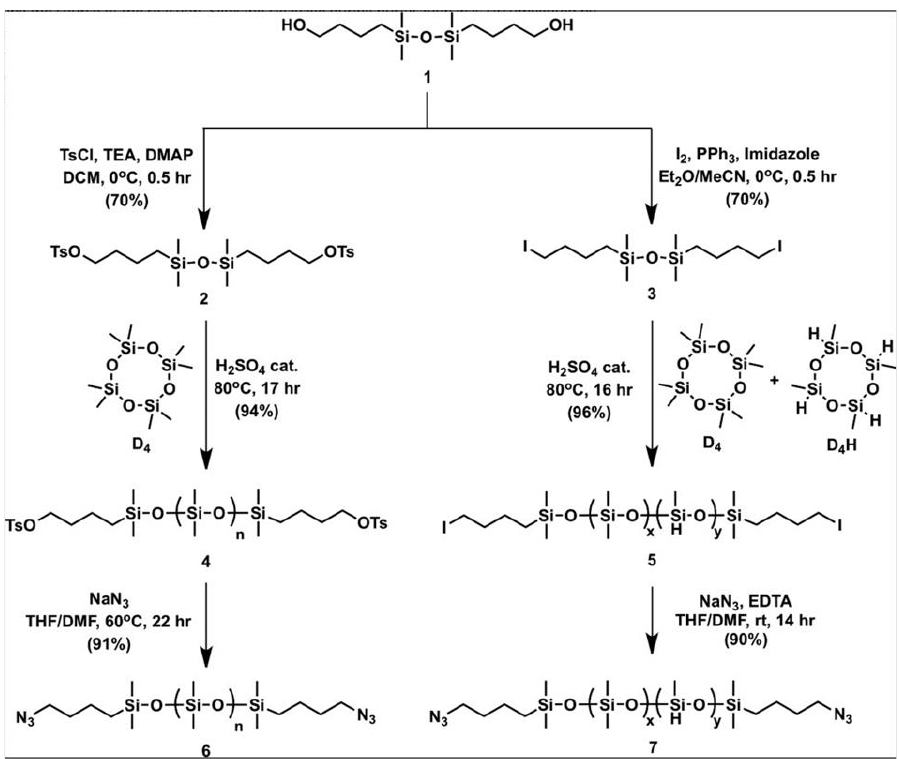
Figure 39. Synthesis of V-PDMPS.